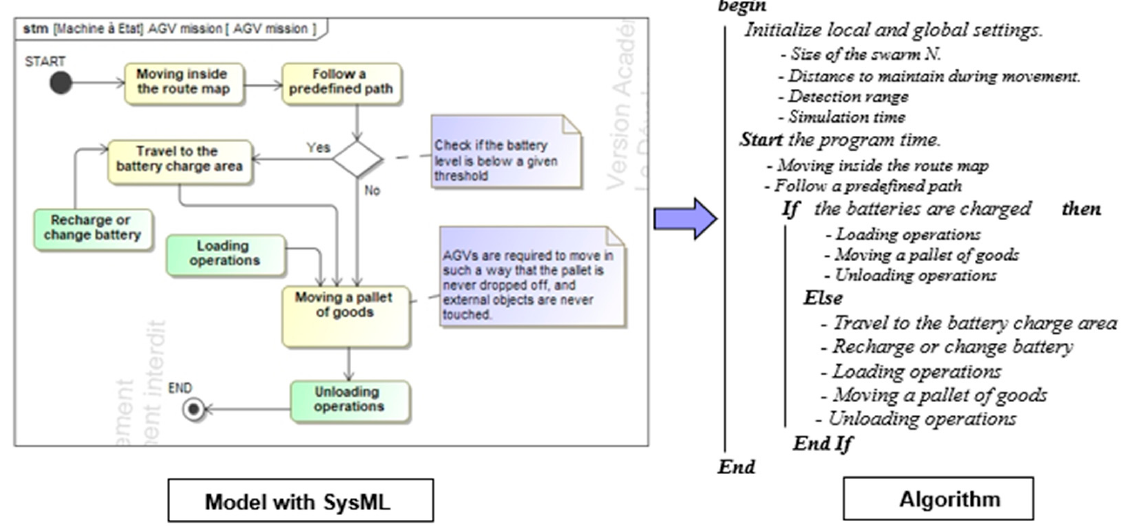
Figure 20. Creation of AGVs operating algorithms using SysML diagram.